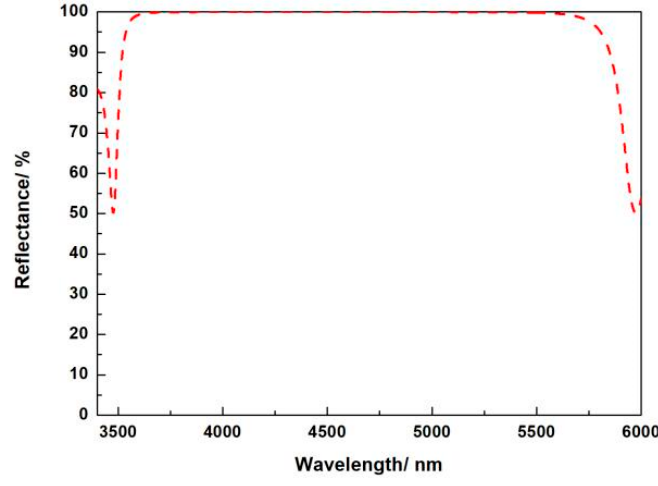
Figure 2. Reflectance spectral curve.